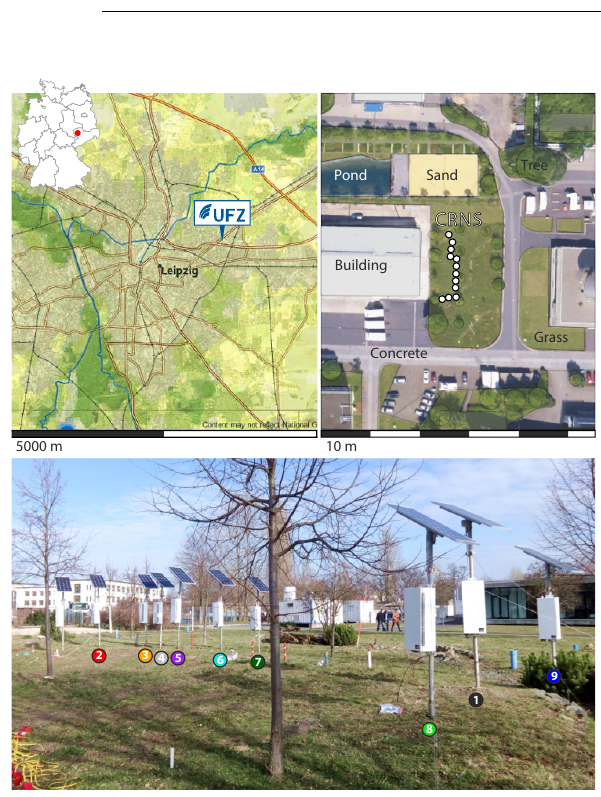
Figure 2. Location and arrangement of the nine cosmic-ray neu- tron sensors deployed at the small, urban meadow at UFZ Leipzig,